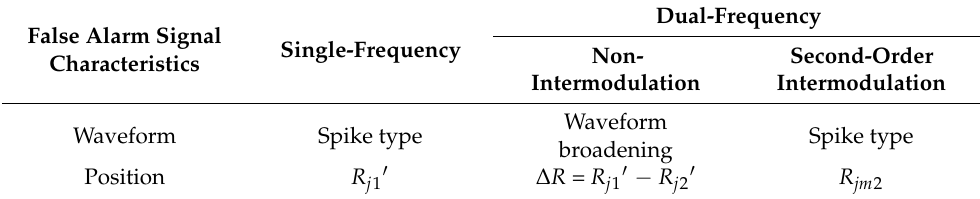
Table 1. Imaging features of false alarm signal. False Alarm Signal